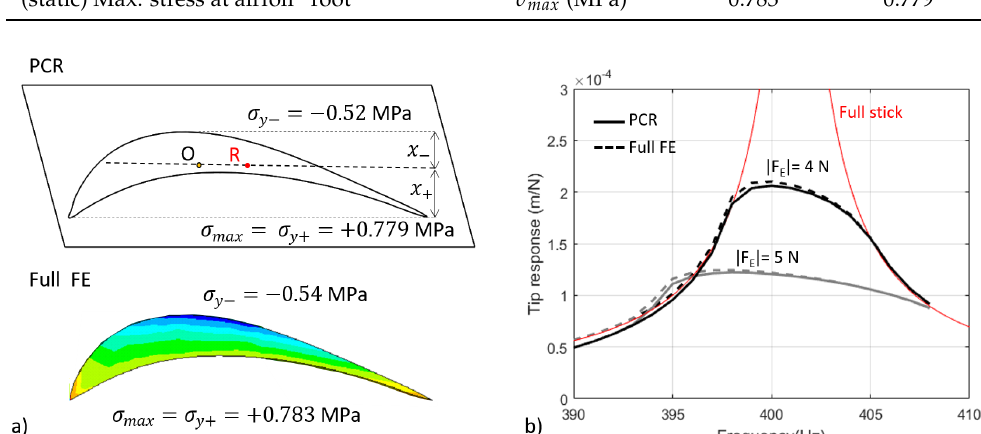
Figure 3. Full FE model vs. PCR model, Blade A. ( a ) Comparison of stresses at airfoil root; ( b ) com- parison of nonlinear forced response results (tip trailing edge, point B) for increasing values of the excitation force | F E | . The response is here normalized by the excitation force magnitude | F E |